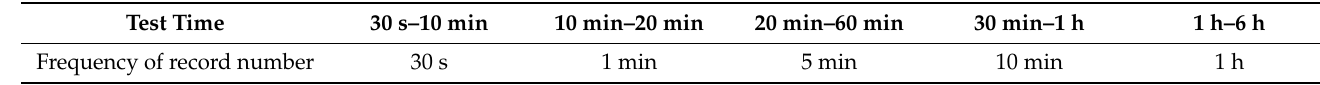
Figure 1. Water absorption testing apparatus: ( a ) Picture; ( b ) Schema. Table 7. The principle for recording the